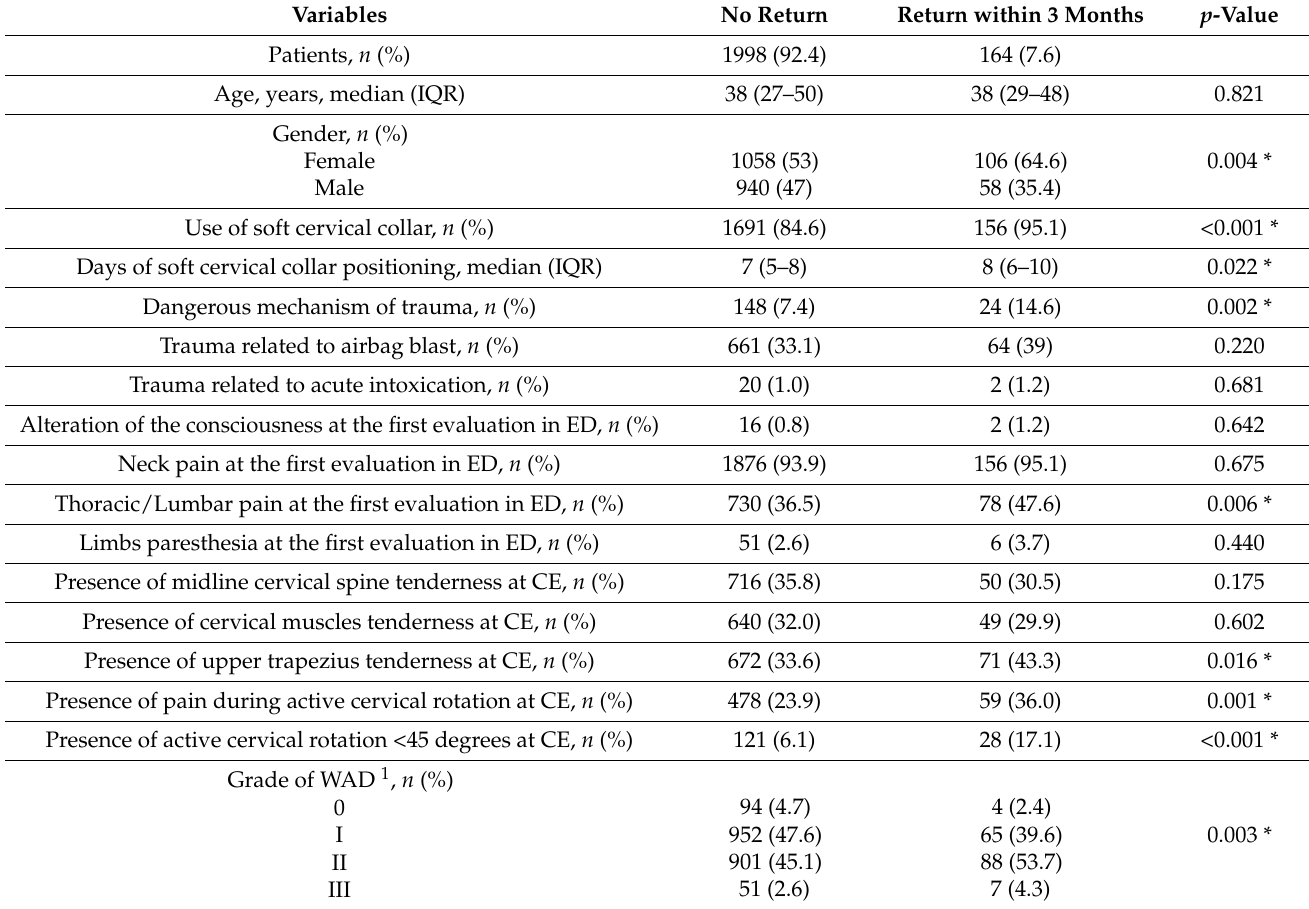
Table 3. Variable associated with a return within three months to the emergency